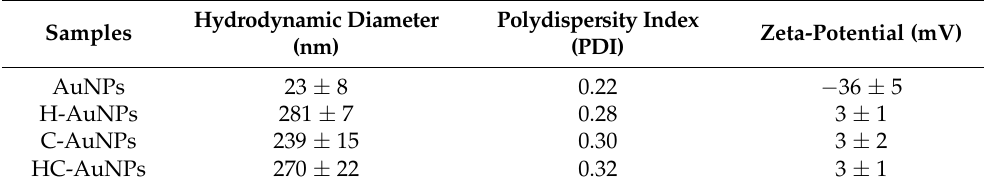
Table 4. Hydrodynamic diameter, polydispersity index, and zeta-potential of AuNPs before and after conjugation with peptides.